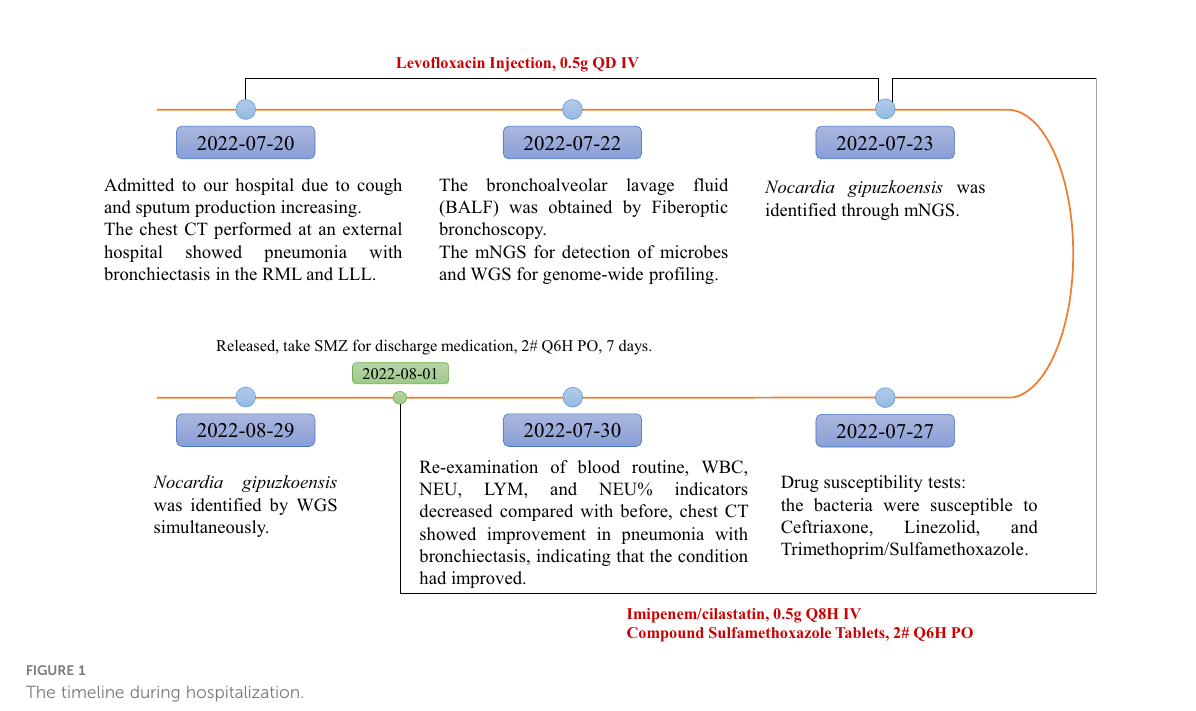
FIGURE 1 The timeline during